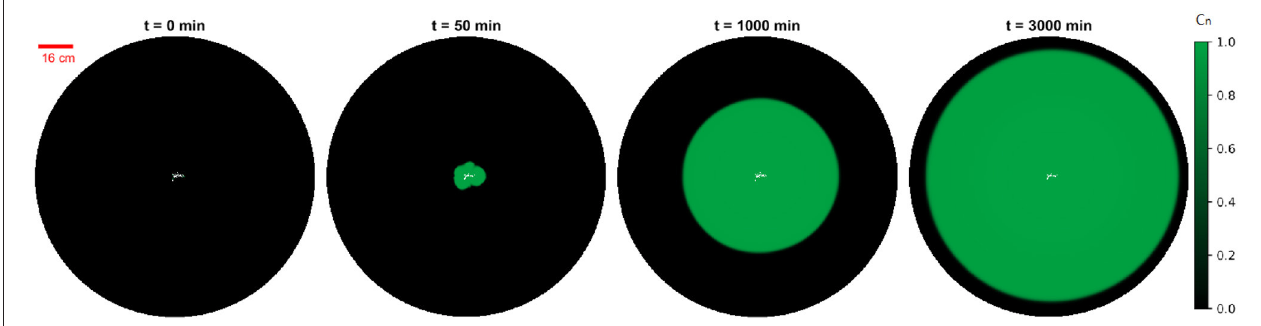
FIGURE 10 | Example of persistence of anisotropy at larger length scales. The simulation images are obtained from the molecular diffusion model, with the same dissolution pattern as before but the whole system is expanded by scale of 8 times. The green intensity represents the normalized tracer concentration C n in the simulation. The images show the concentration profile after an injection lasting respectively 0 / 50 / 1,000 / 3,000 min . We observe that the anisotropy of the concentration profile vanishes gradually with time.